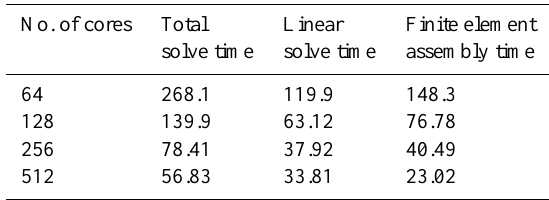
Table 7. Total, linear solve and finite element assembly times (s) for variable resolution 1–7km resolution GIS problems as a function of the number of cores of Hopper .